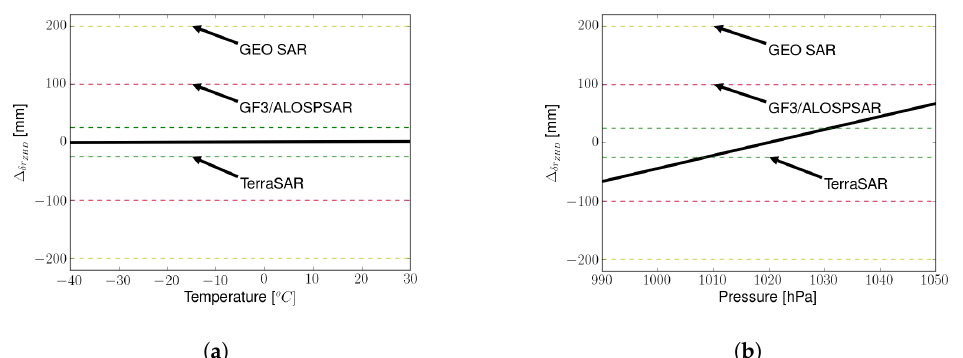
Figure 4. Bias of ZHD along with the variation of the pressure ( a ) and temperature ( b ).